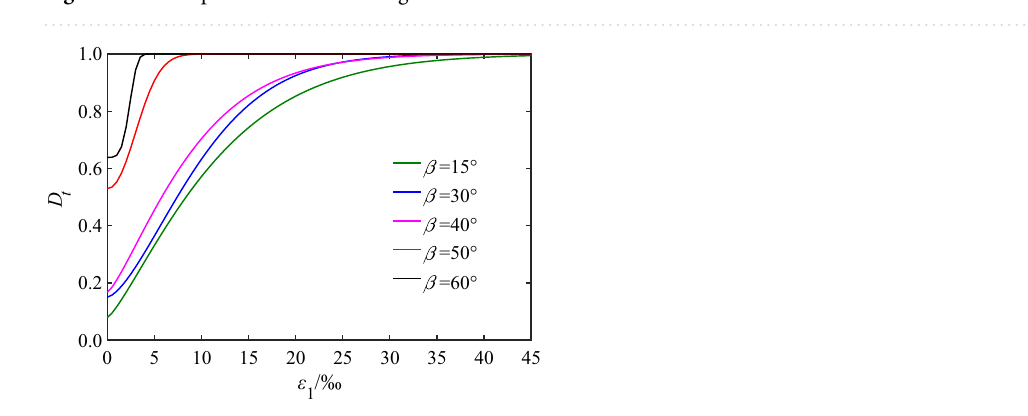
Figure 5. Correspondence of the damage evolution curve and stress–strain curve.